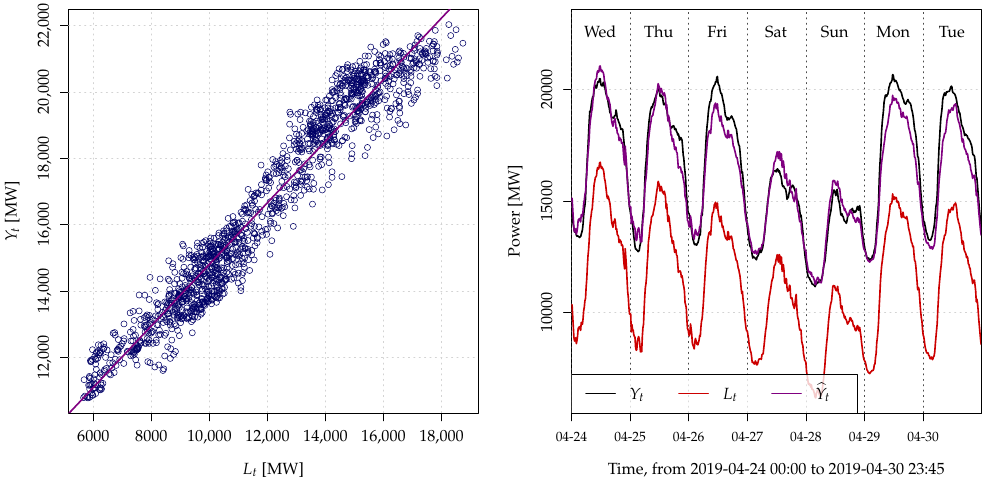
Figure 2. (Left) Scatter plot of the process L t (see (3)) and load Y t in April 2018 with the fitted line of Model (4). (Right) Time series plot of Y t , L t , and (cid:98) Y t = (cid:98) α 0 + (cid:98) α 1 L t for the last week of April 2019 as in Figure